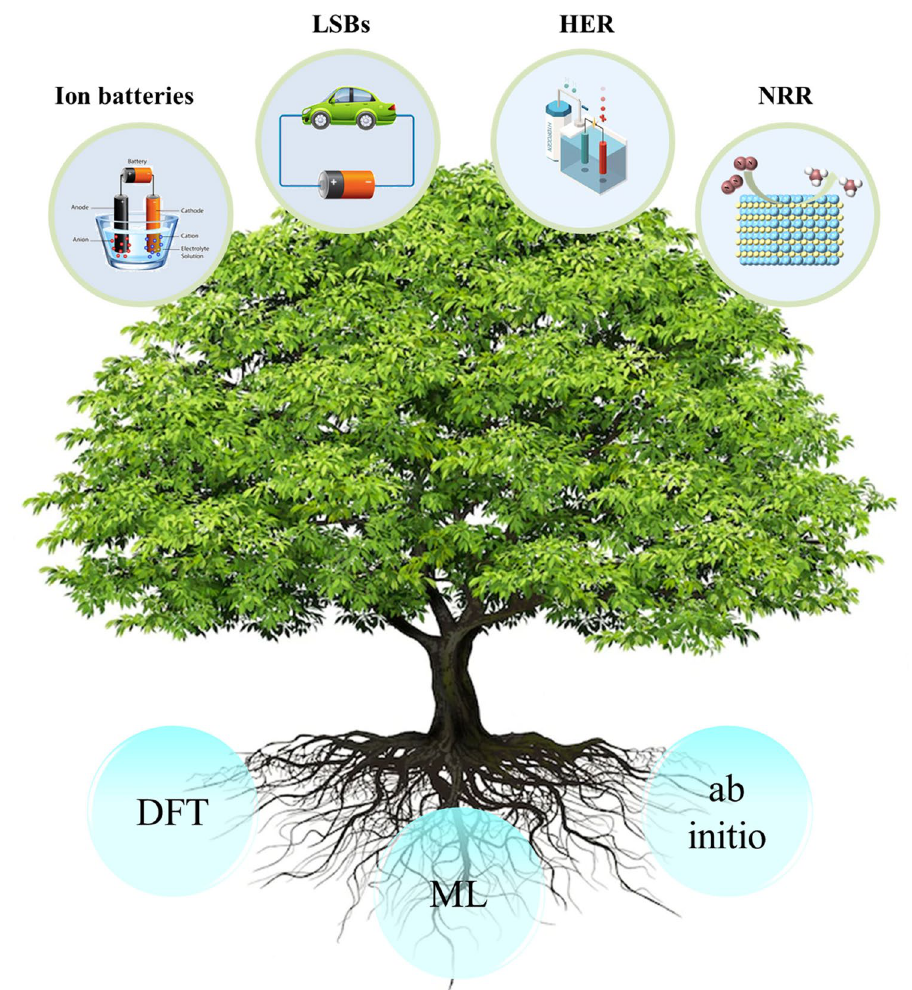
Fig. 25 Main applications of MBenes in energy storage and conversion with theoretical